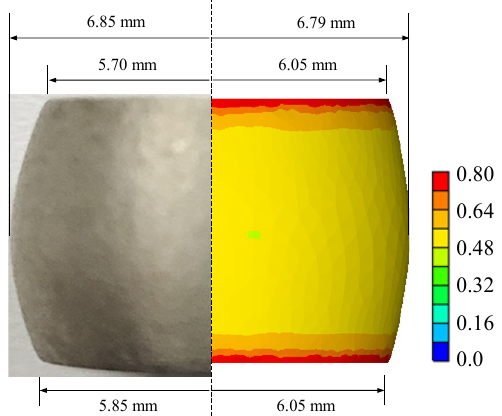
Figure 8. Predicted temperature ( left ) and effective strain ( right ) at the final stroke of cylinder com- pression test at the 450 °C temperature and 10 s − 1 strain rate.